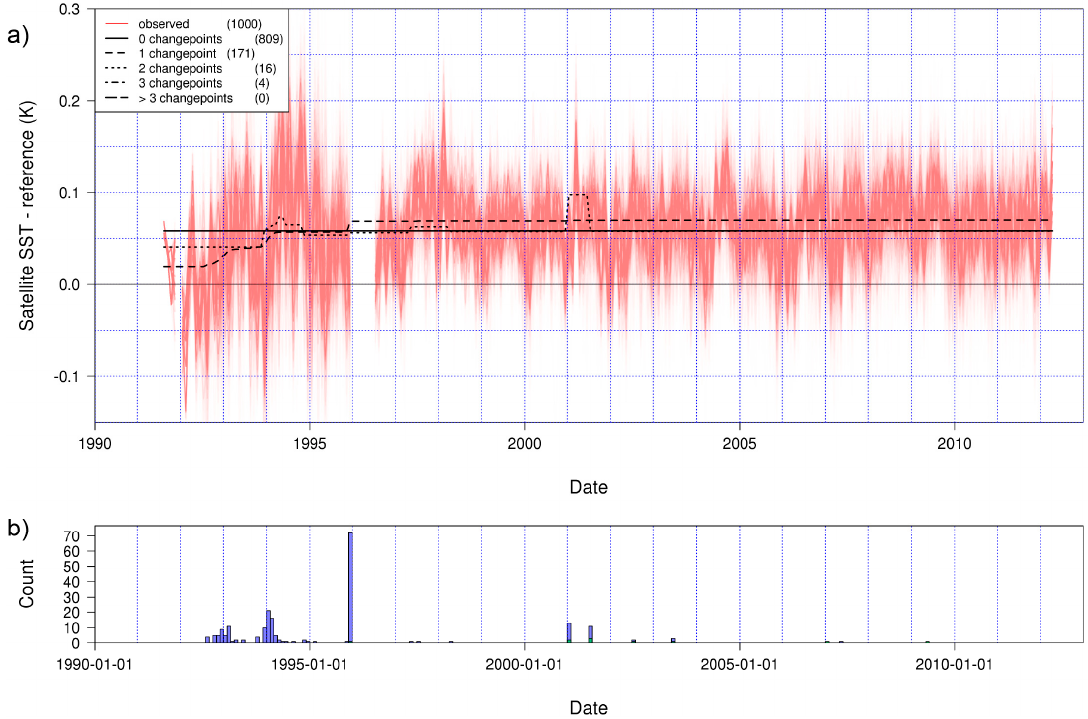
Figure 4. Results of the ensemble application of PMT using the GTMBA. ( a ) The monthly mean differences (satellite in situ) for the individual ensemble members are shown in red. Also shown are the means of the model fitted by PMT grouped by number of change points detected. ( b ) Histogram of the data of the change points detected across all ensemble members.